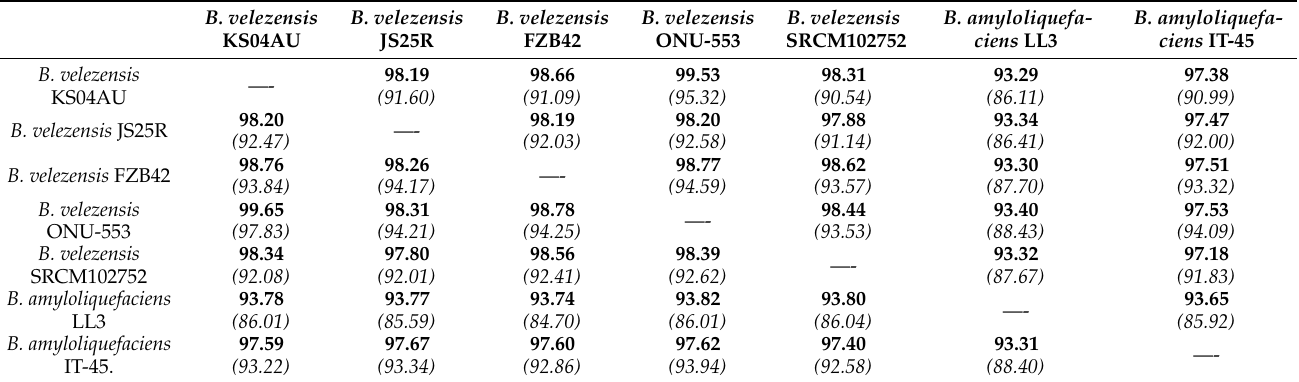
Table 3. Genomic comparative analysis of B. velezensis KS04AU with 6 closest related Bacillus species based on ANI (average nucleotide identity).